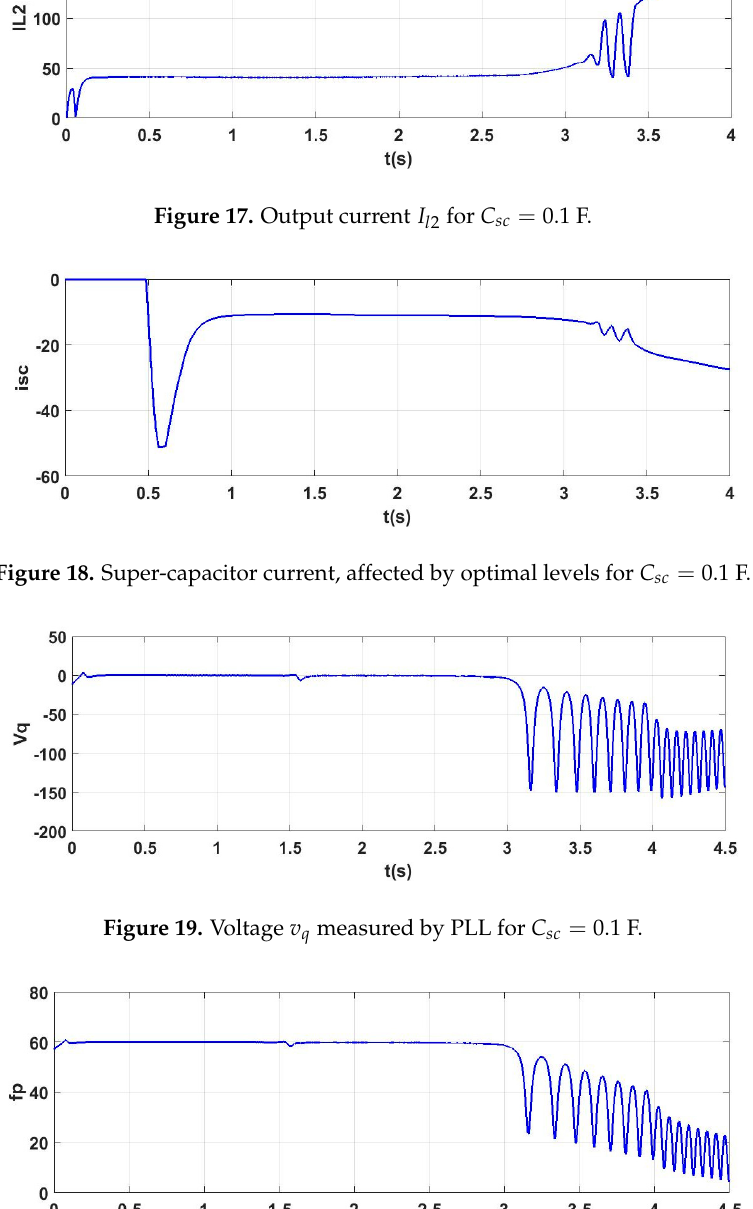
Figure 20. Output frequency of PLL for (cid:1829) (cid:3046)(cid:3030) = 0.1 F.